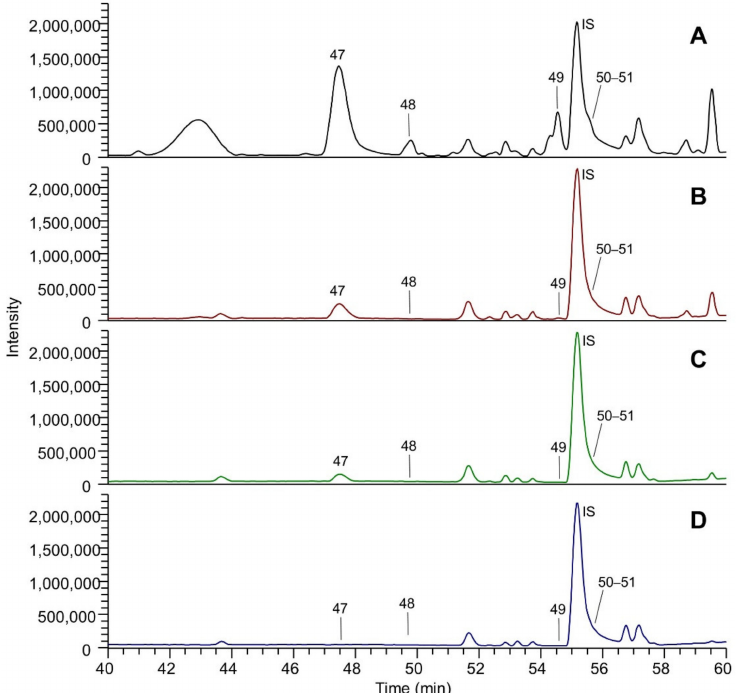
Figure 4. Magnification (range time 40–60 min) of the LC-ESI-(-)-MS total ion currents (TICs) recorded in negative ion mode of the four extracts: ( A ) EtOH-H 2 O 70:30 (% v / v ); extract A; ( B ) water at 100 ◦ C, extract B; ( C ) water at 70 ◦ C extract C; ( D ) water at room temperature, extract D. Identified peaks (group C) are numbered progressively based on the RT and their assignment is reported in Table